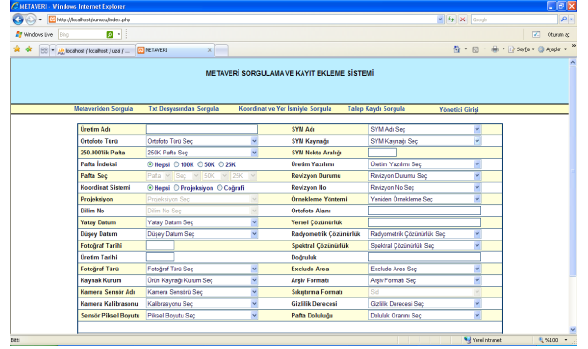
Figure 5. Metadata matched with the search